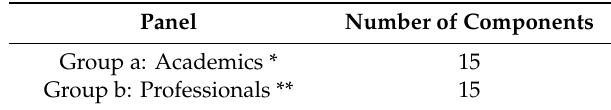
Table 1. Composition of panel.